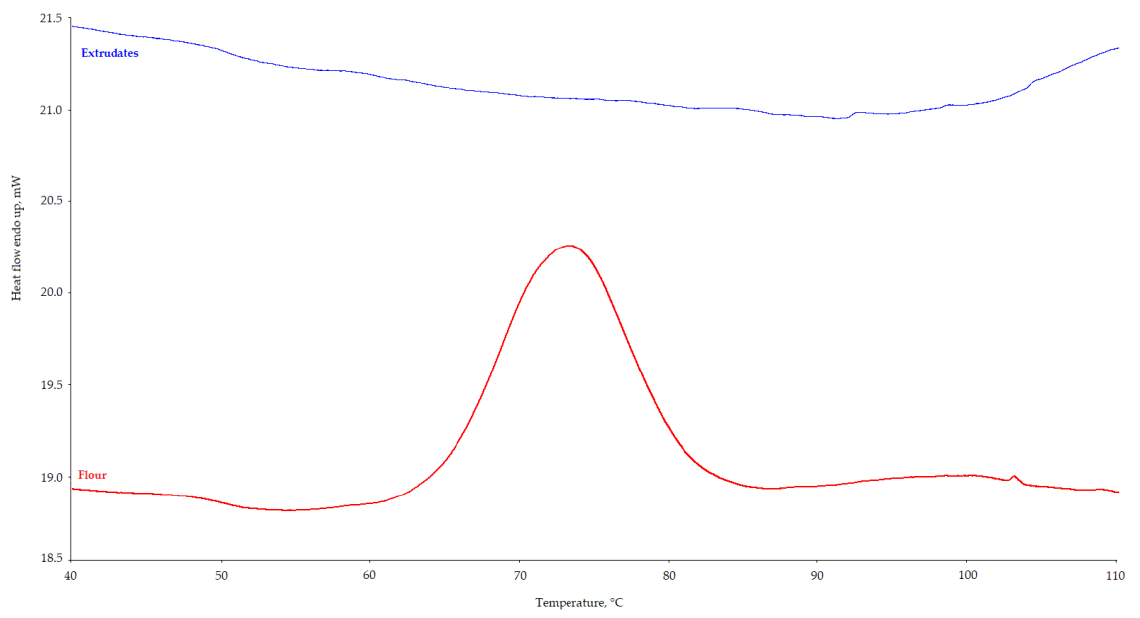
Figure 2. DSC curves for the flour mixture before extrusion (red curve) and extrudate sample (blue curve).